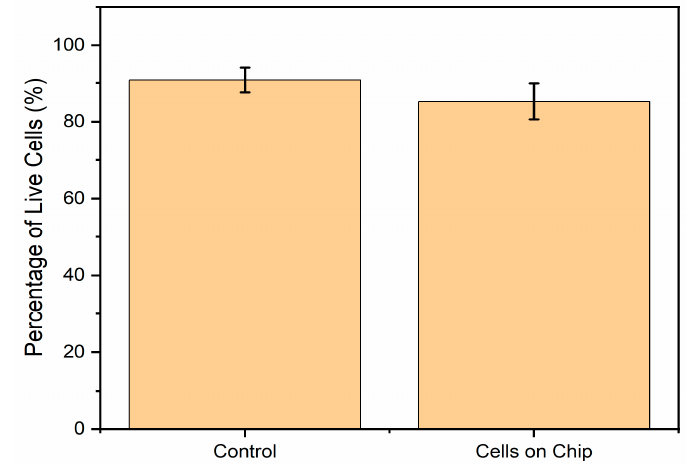
Figure 8. Percentage of live cells indicating that cell viability was approximately 85%.